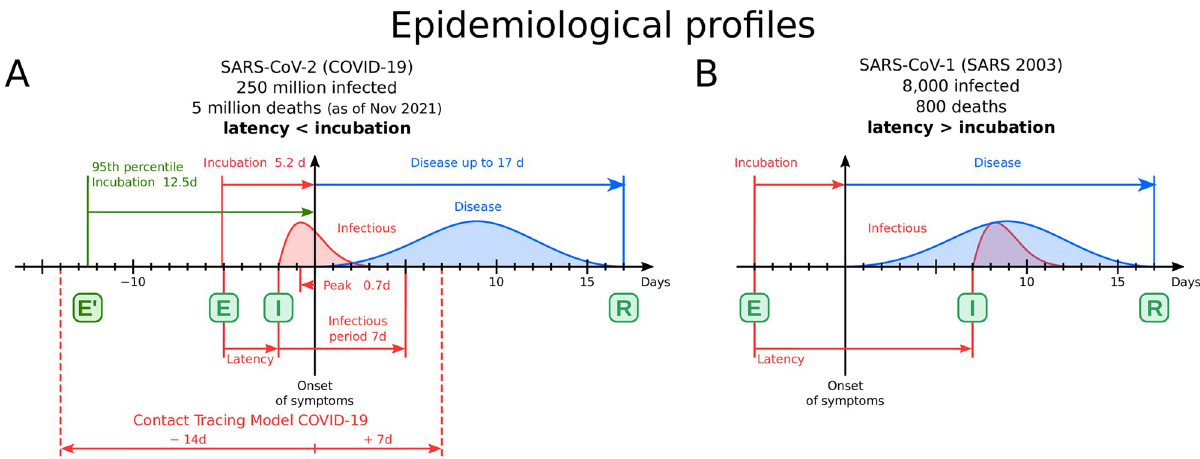
Fig 1. Infectiousness profiles of SARS-CoV-1 and SARS-CoV-2. (A) Infectiousness profile of coronavirus SARS-CoV-2 responsible for COVID-19. The COVID-19 pandemic is modeled by a SEIR model. From exposure (E) the virus is incubated in average for 5.2 days (12.5 days 95 th percentile), starting the symptoms 2 days after infectiousness (I) and lasting the disease up to 17 days to recover (R). We use a window -14/+7 days from the first symptoms to detect infectious and exposure. (B) Infectiousness profile of coronavirus SARS-CoV-1 responsible for SARS-2003. Data obtained from [25]. As opposed to COVID-19, we note that in this case the latency is longer than the incubation period, and the peak of infectiousness then appears after the onset of symptoms. Thus, when the patients present its first symptoms, upon isolation, the transmission of disease is interrupted. In this case, isolating the patients after the symptoms is an effective way to control the pandemic. On the contrary, COVID-19 in (A) is characterized by a latency shorter than incubation, and, even more troublesome, with a pre-symptomatic peak of transmission appearing before the onset of symptoms. Thus, in this case, even if the patient isolates after the symptoms appear, most of its infections have occurred already. This indicates that the only way to stop the chain of transmission of COVID-19 is by going into the past, before symptoms, and performing contact tracing to capture and isolate the contacts of the infected person before the symptoms have appeared. This crucial difference in the epidemiological profiles of these two coronaviruses might explain why SARS was contained successfully in 2003 producing around 8,000 infections and 800 deaths, while COVID-19 kept spreading reaching a much larger worldwide population of 250 million infections and 5 million deaths as of November